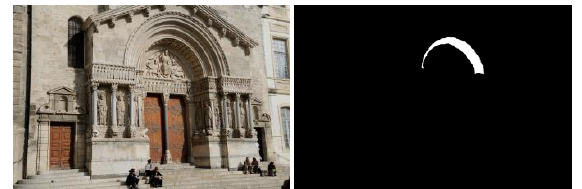
Figure 13: Image (left) and associated mask by the propagation of annotation (right) In the event that the drawn area (corresponding to the annotation) does not appears in one of the other images, the created mask for this image will be only composed of black pixels. Figure 15: Steps of multi-view definition: (a) definition of a part of the annotation on a view and search of X, Y and Z coordinates (pink), (b) definition of a second part of the annotation on another view and search of X, Y and Z coordinates (blue), (c) association of the two list of coordinates (green), (d) projection of the modified annotation on others